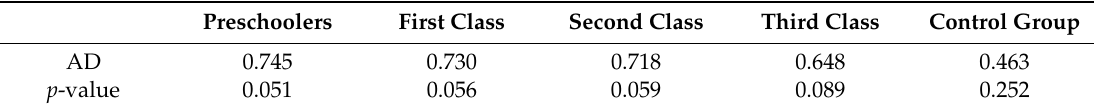
Table 2. Anderson-Darling test